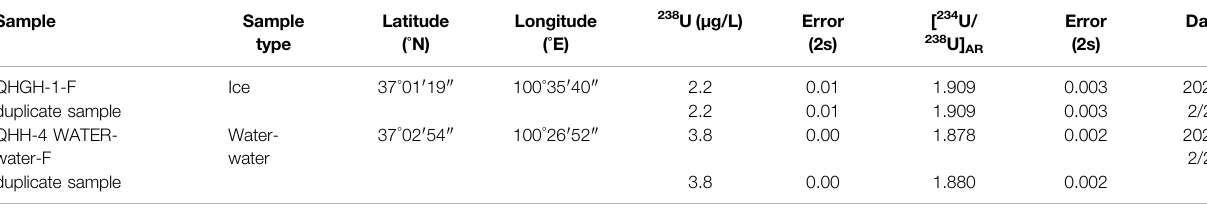
TABLE 3 | Data information of samples and duplicate samples during chemical analysis. Sample